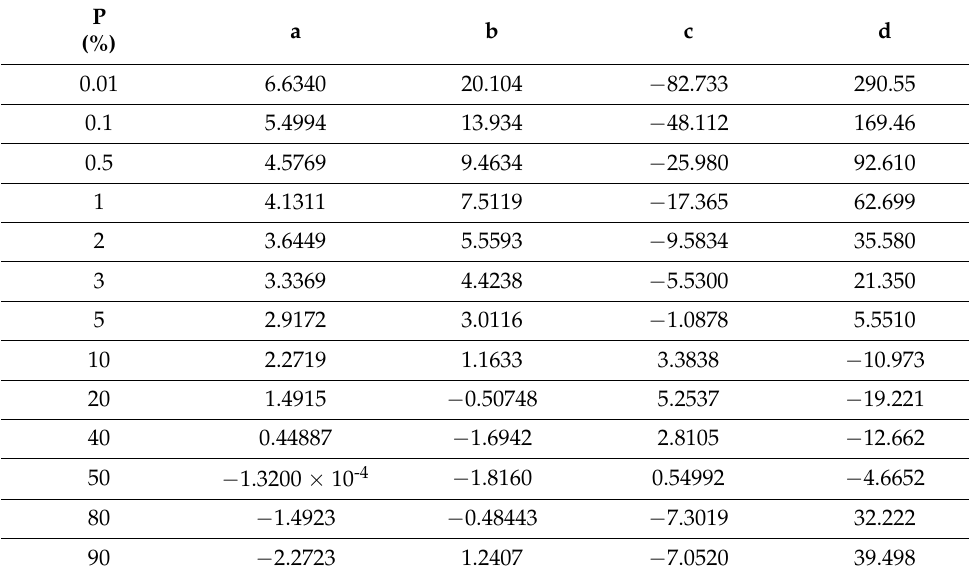
Table A9. The frequency factor for estimation with L-moments for